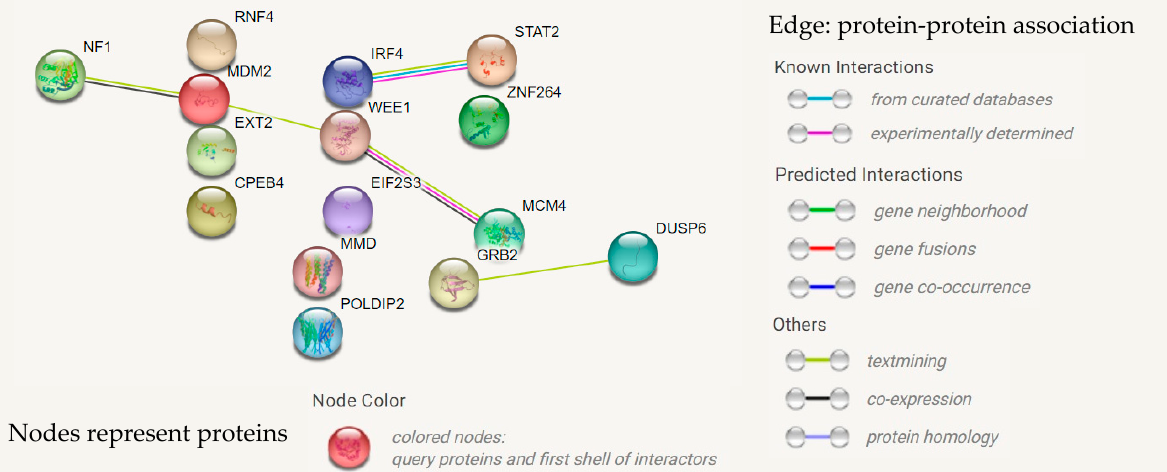
Figure 7. Network analysis of 15 proteins encoded by 15 investigated genes using STRING database version 11.5. The option “Multiple Proteins by Names/Identifier” of “Search” domain was used. Visualization of interactions and notations is according to the output of